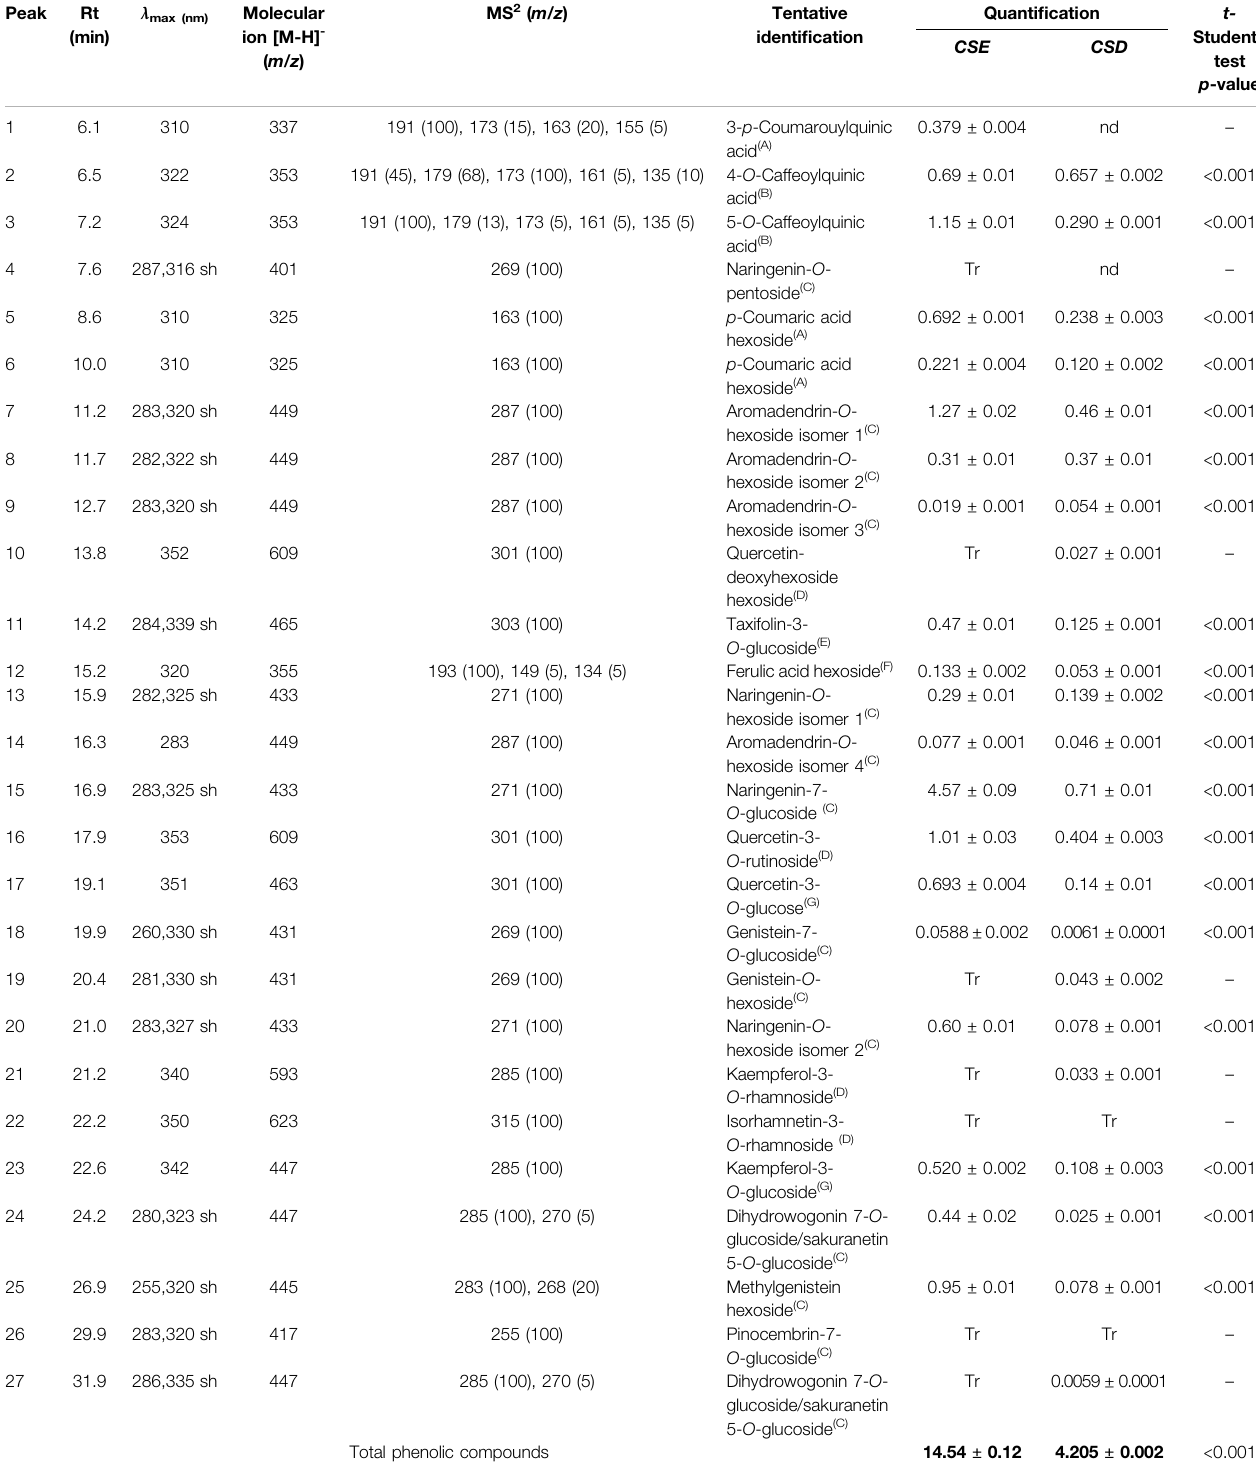
TABLE2| Retentiontime(Rt),wavelengthsofmaximumabsorptioninthevisibleregion( λ max ),massspectraldata,tentativeidenti fi cationandquanti fi cation(mg/gofextract) of the phenolic compounds present in CSE and CSD.